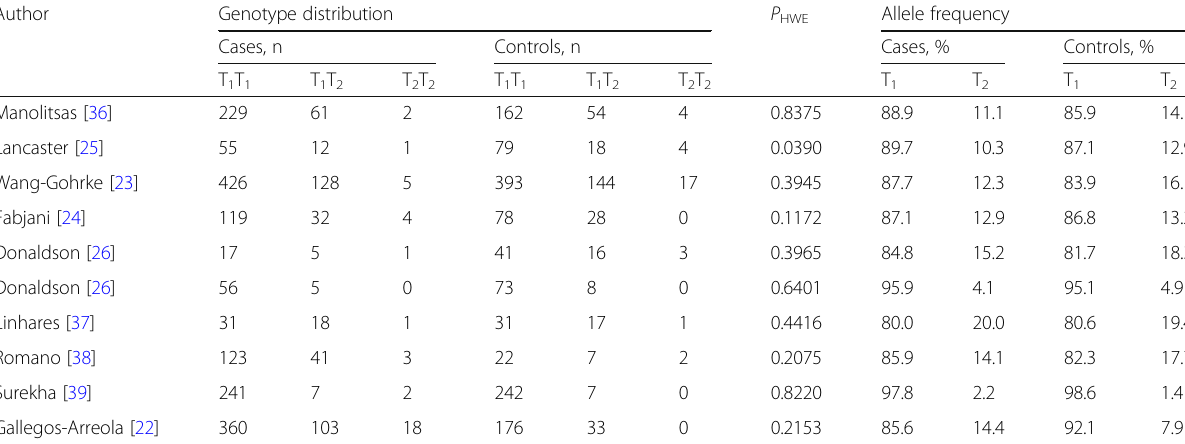
Table 2 Distribution of genotype and allele frequencies of the PGR Alu insertion